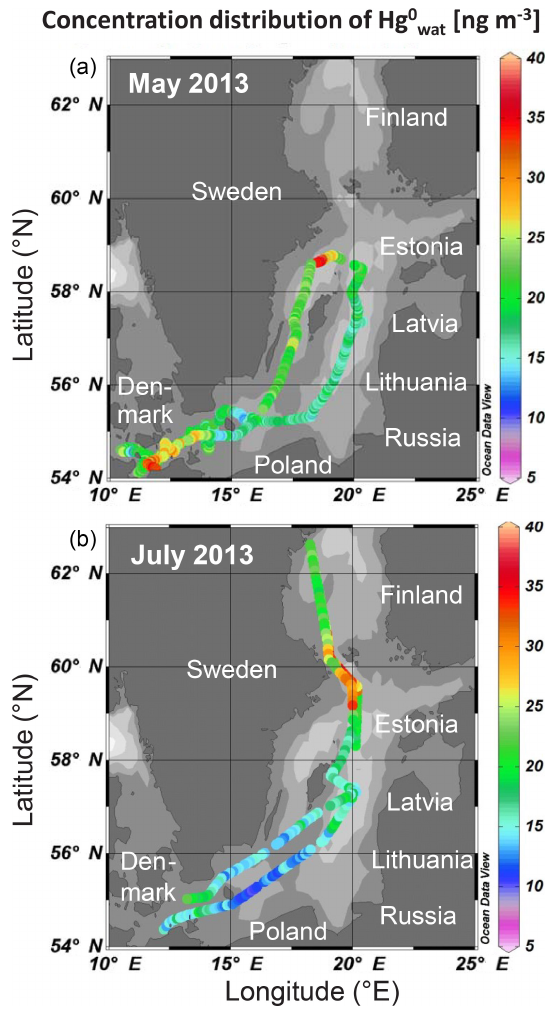
Figure 2. The Hg 0 surface water concentration in the Baltic Sea as determined from high-resolution Hg 0 wat measurements conducted in May 2013 (a) and July 2013 (b) was plotted by using Ocean Data View (Schlitzer,